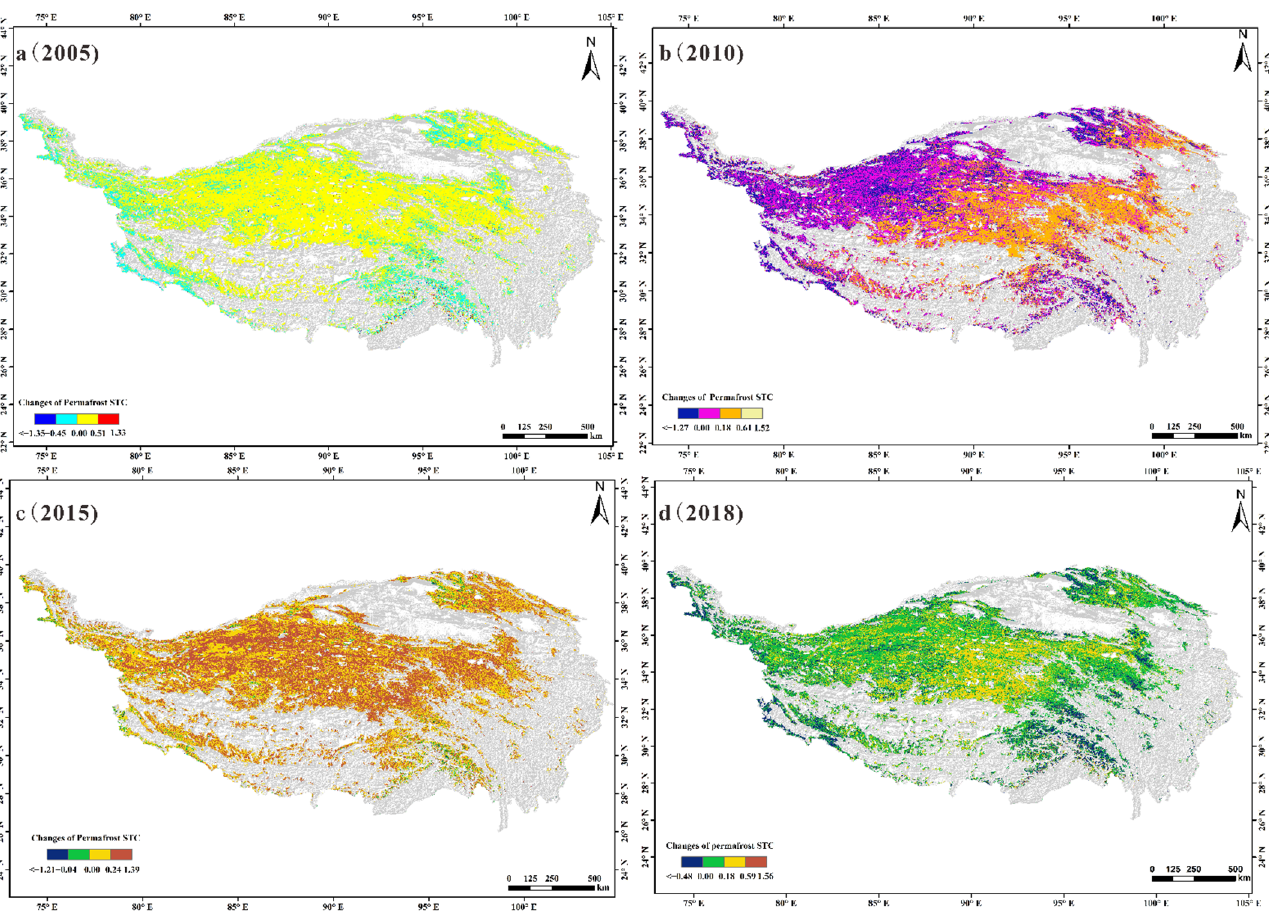
Figure 13. Spatial distribution of STC difference value (=STC thawing − STC freezing ) during the thawing ( a , c ) and freezing periods ( b , d ) in the permafrost zone of the Qinghai–Tibet Plateau from 2005 to 2018.